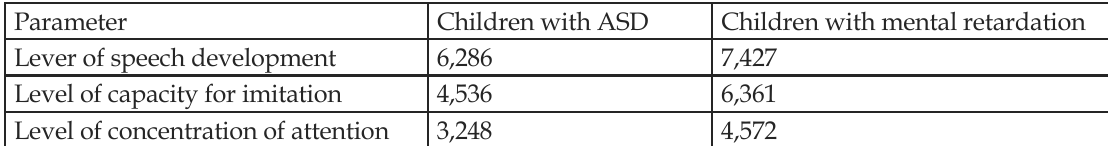
Tab. 1. A comparison of parameters of children with ASD and mental retardation.